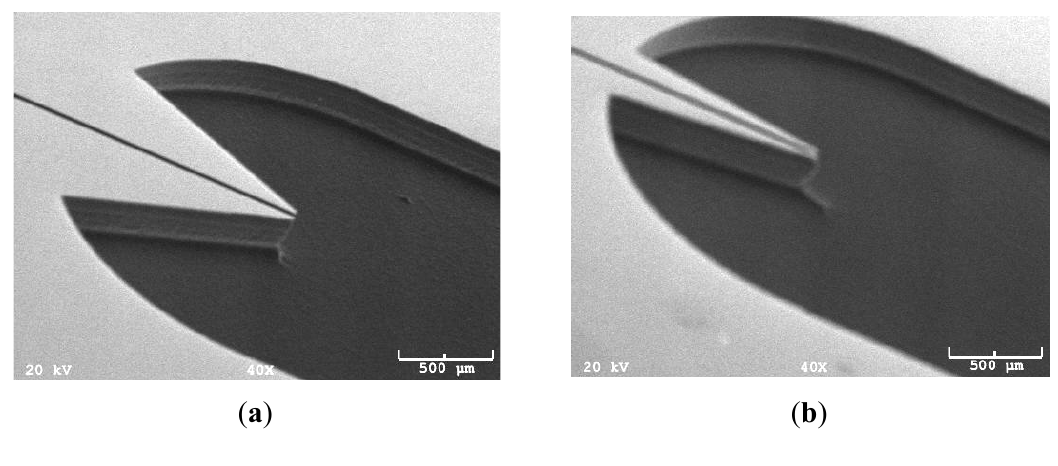
Figure 4. SEM images of the etched capillary channel and stop valve profile. ( a ) The capillary channel is 10 µm wide and the expanding angle of the stop valve is 170°. ( b ) The capillary channel is 15 µm wide and the expanding angle of the stop valve is